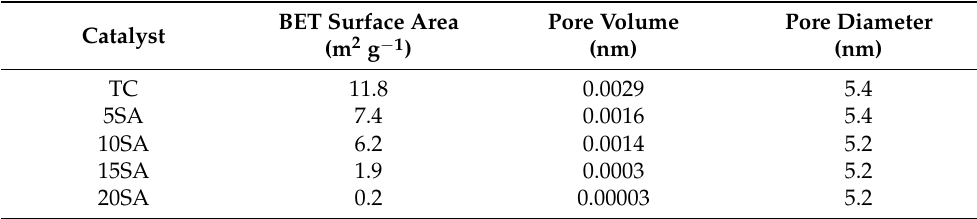
Table 1. The BET surface area and porosity of non-sulphated and sulphated-titania catalysts at various concentration. Catalyst